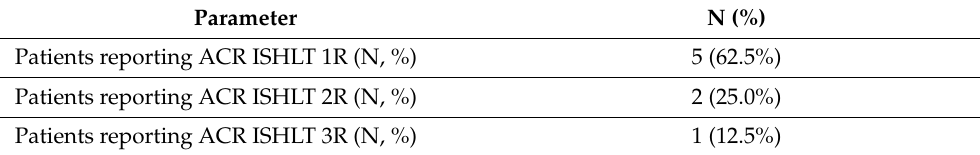
Table 4. Patients’ acute cellular rejection (ACR) grading.